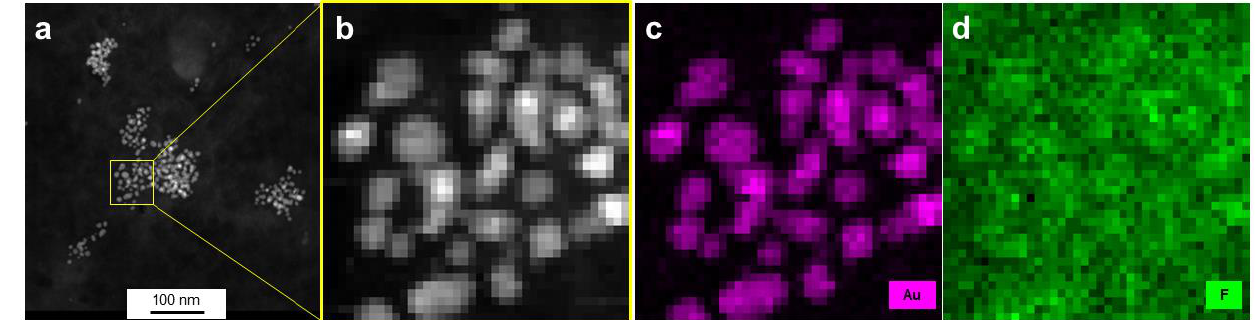
Figure 5. HAADF-STEM images ( a , b ) and EDX elemental mapping ( c , d ) of AuPVA-CB839 NPs. Gold, corresponding to the NPs is shown in pink and fluorine contained in CB839 in green.